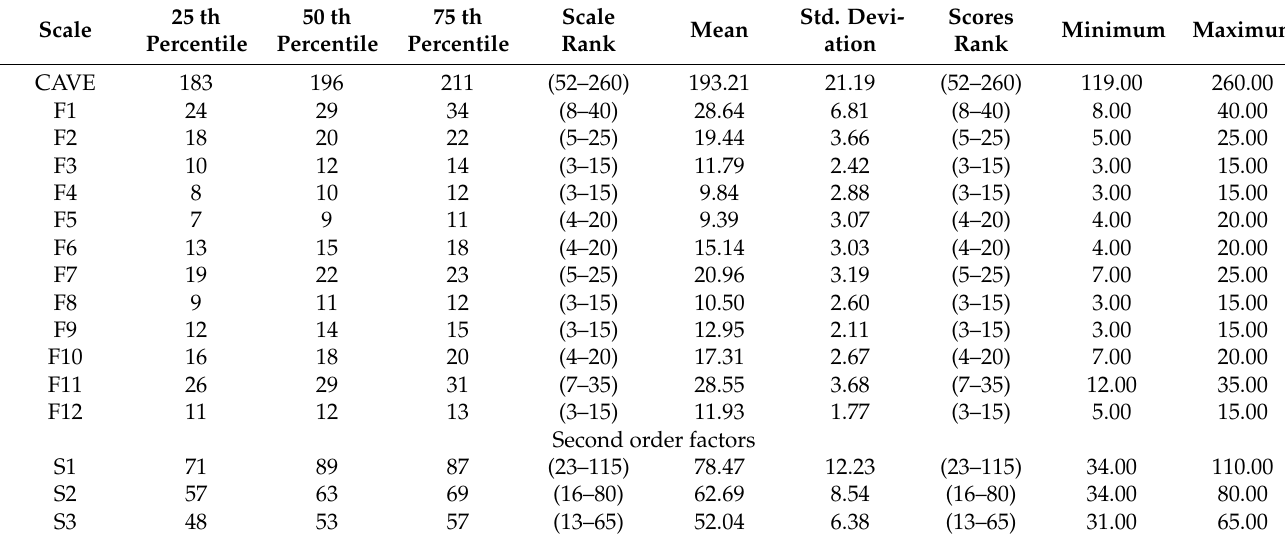
Table 6. Descriptive statistics for the